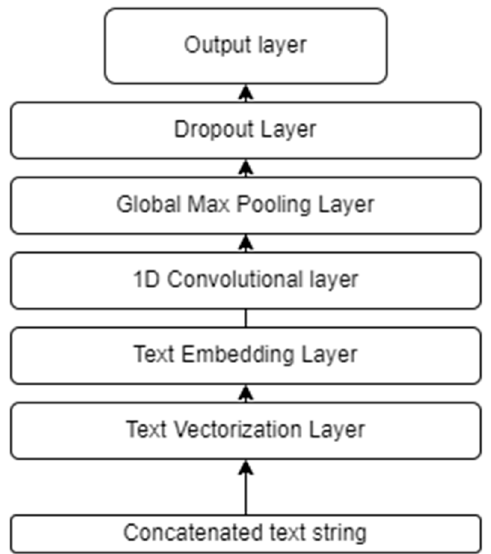
Figure 1. Network architecture, model trained from scratch.